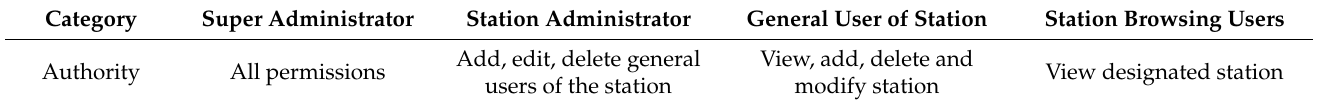
Table 3. System classification and authority.